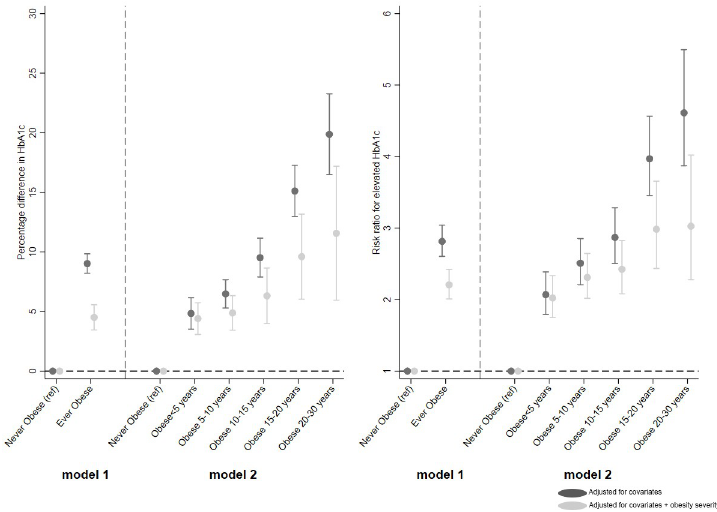
Fig 2. Association between ever obese and categories of obesity duration (versus never obese) and HbA1c (left panel) and risk for elevated HbA1c (right panel).